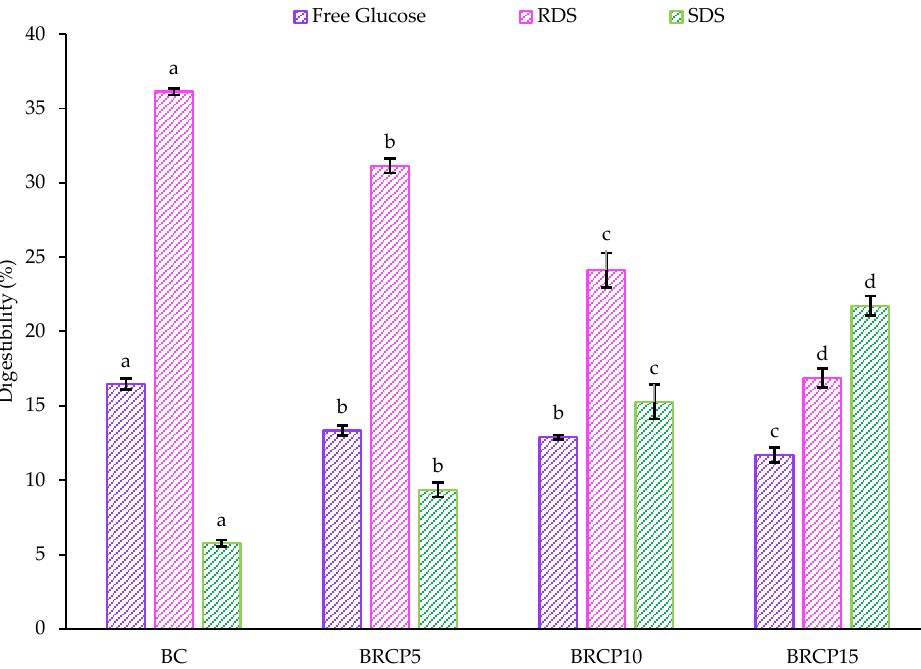
Figure 2. Free Glucose (FG), Rapidly Digestible Starch (RDS), and Slowly Digestible Starch (SDS) of biscuits enriched with RCP. Results are expressed as means ± SD ( n = 3) on a dry weight basis. Values followed by different letters in the same line are statistically different with Tukey’s test ( p < 0.05). BC = Biscuit control; BRCP5 = Biscuit enriched with 5% roselle calyx powder; BRCP10 = Biscuit enriched with 10% roselle calyx powder; BRCP15 = Biscuit enriched with 15% of roselle calyx powder.